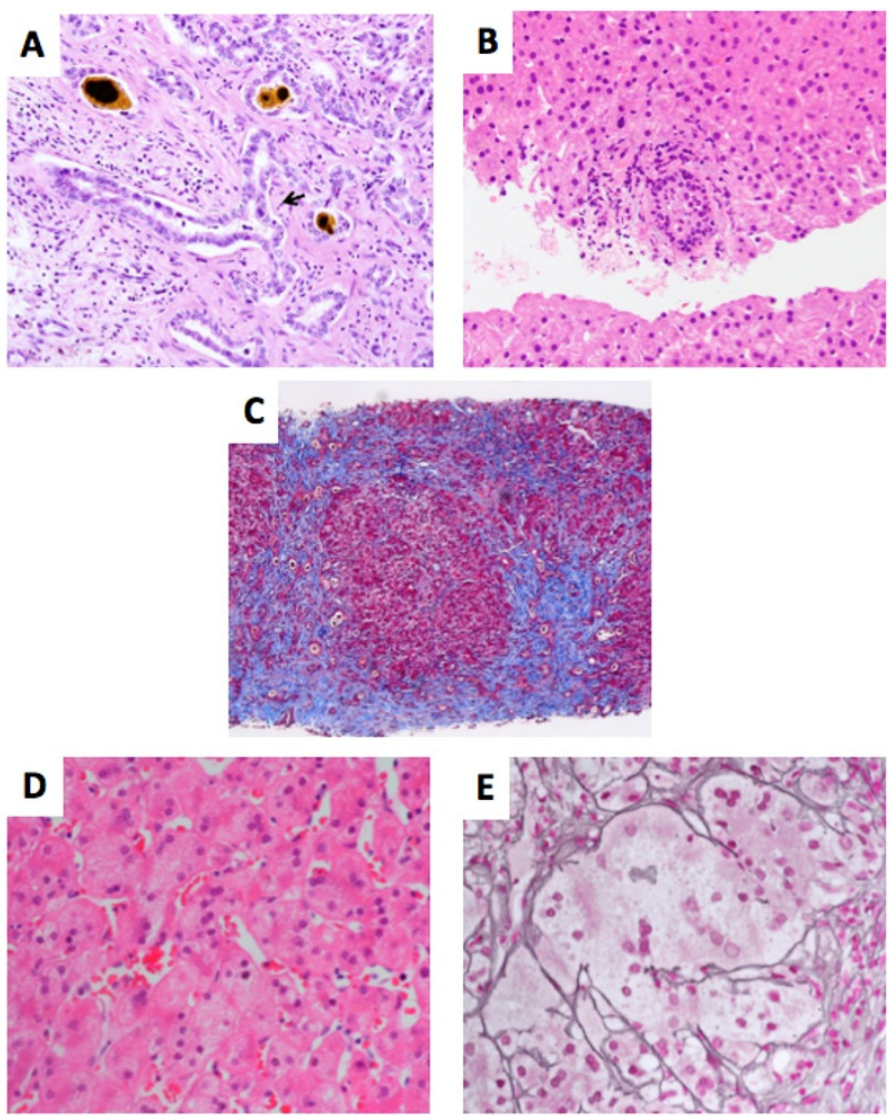
Figure 1. Histology findings found to be statistically significant ( p < 0.05: ( A – C )) or a statistical trend ( p < 0.1: ( D , E )) with either TFS or DB level at 3 months after KPE using univariate analysis. (Legend: ( A ): DPM; ( B ): acute cholangitis; ( C ): portal fibrosis; ( D ): multinucleated giant cells; ( E ): syncytial giant cells) (( A ): Cytokeratin-19 stain; ( B , D ): hematoxylin and eosin stain; ( C ): Trichrome Masson stain; ( E ): reticulin